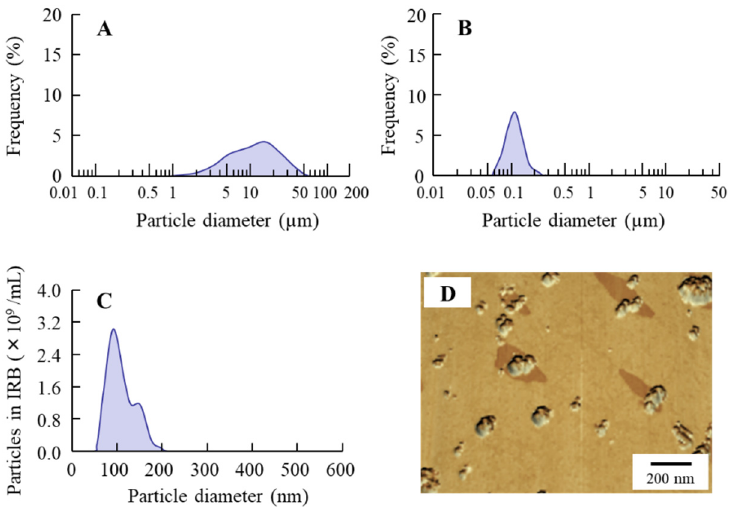
Figure 1. Particle sizes of IRB in IRB-NP suspensions. ( A ) Particle size frequencies of IRB in IRB-MP suspensions as determined by the SALD-7100; ( B , C ) particle size frequencies of IRB in IRB-NP suspensions determined by the ( B ) SALD-7100 and ( C ) NANOSIGHT LM10, respectively; and ( D ) AFM image of the IRB in IRB-NP suspensions. Bars show 200 nm. The particle size of the IRB-NP suspensions was approximately 50–200 nm.